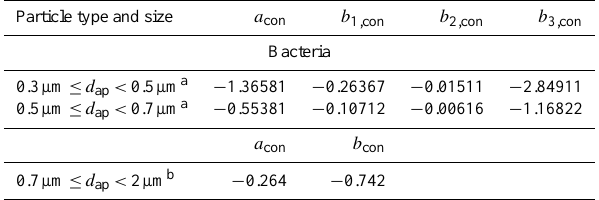
and particle sizes (marked by different line